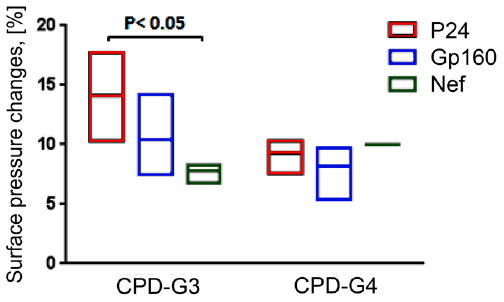
Figure 7. Changes in the surface pressure of monolayers formed by DMPC–DPPG lipid systems following addition of dendriplexes into the buffer subphase onto which the lipid monolayer with initial surface pressure of 30 mN/m was formed. Results represent mean ± S.D. n = 3. Statistically significant differences in comparison to the control ( p <